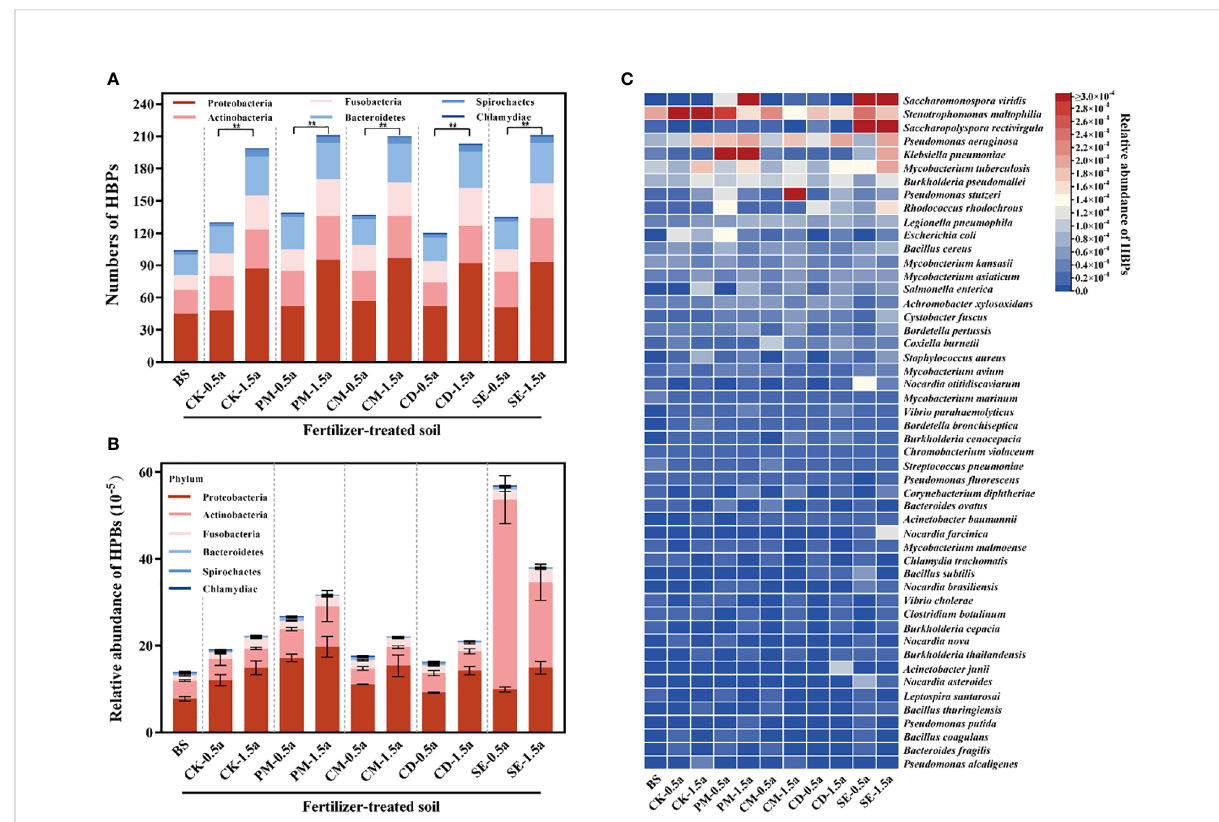
FIGURE 3 Diversity and abundance of human bacterial pathogens (HBPs) among different soils. (A) Number of detected HBPs. (B) Relative abundance of HBPs. (C) Heat map showing the abundance of HBPs that are detected in different samples. Signi fi cant differences between two treatment groups with **P <